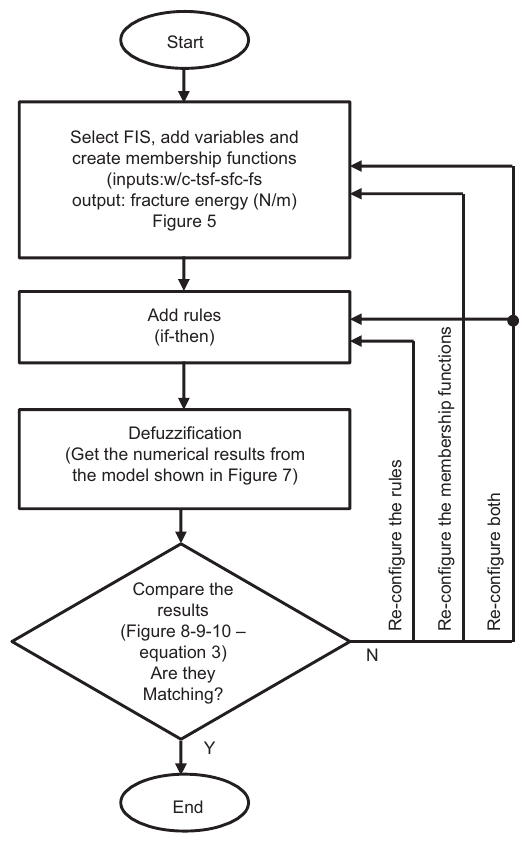
Figure 3 Flow diagram for this